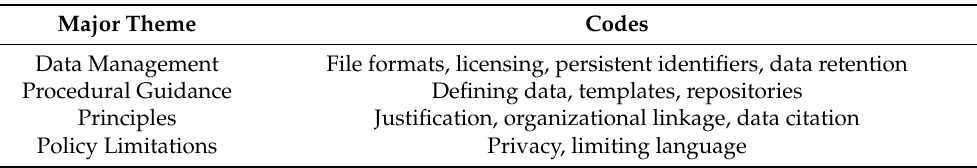
Table 1. Major themes and associated codes developed through qualitative analysis of library and information science (LIS) journal research data